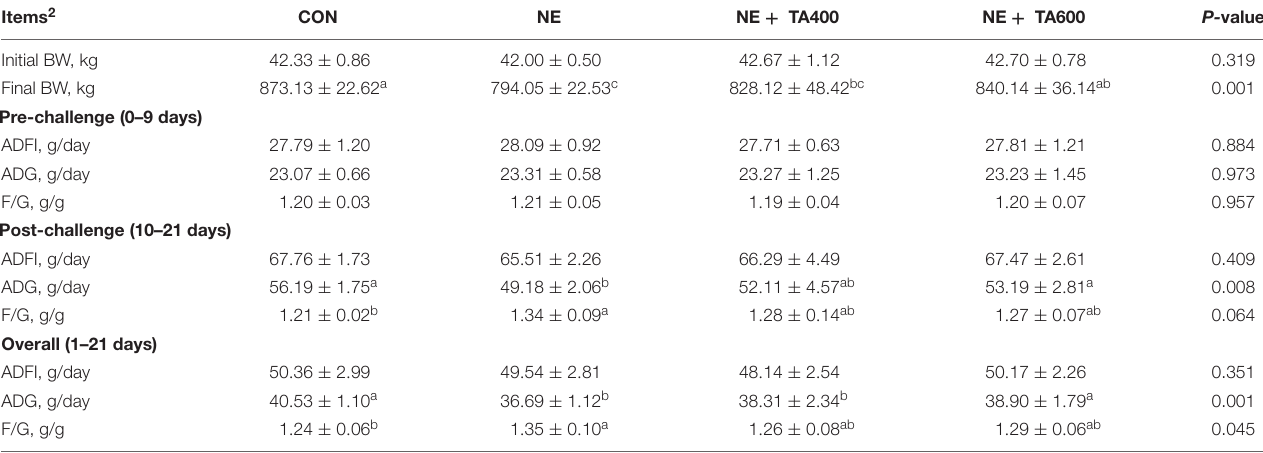
TABLE 1 | The effect of dietary TA supplementation on the growth performance of broilers challenged with subclinical necro-hemorrhagic enteritis 1 . Items 2 CON NE + TA400 NE +